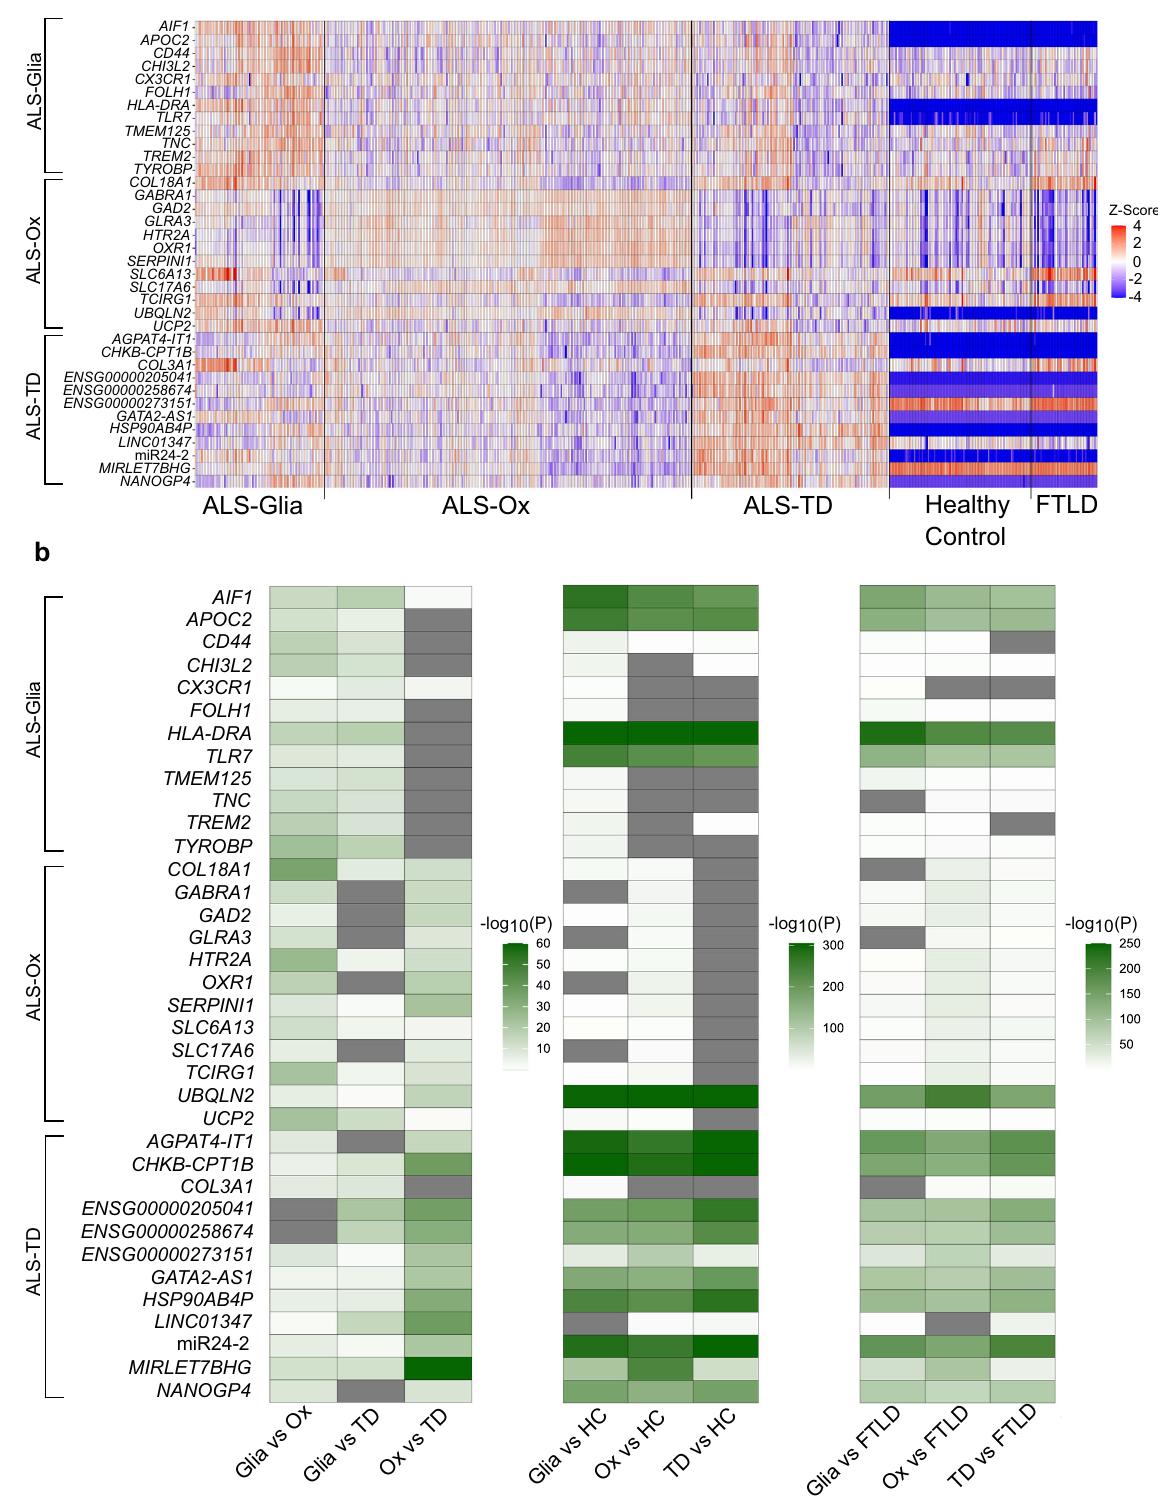
Fig. 6 | Subtype-speci fi c gene expression. a Heatmap showing expression of 36 subtype-speci fi c transcripts for all patient samples considered in this study. Count values are adjusted for RIN, site of sample preparation, and sequencing platform covariates.Expressionisz-scorenormalized,usingALSpatientexpressiontode fi ne the mean and standarddeviation. Control samples witha z-score< – 4 are adjusted to – 4 for plotting purposes. b Presentation of FDR-adjusted p -values following